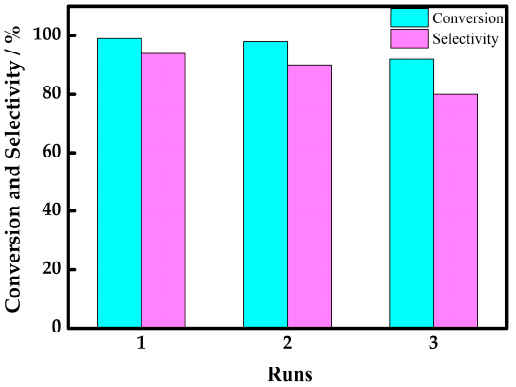
Figure 2. The conversion and selectivity histogram of every recycle.